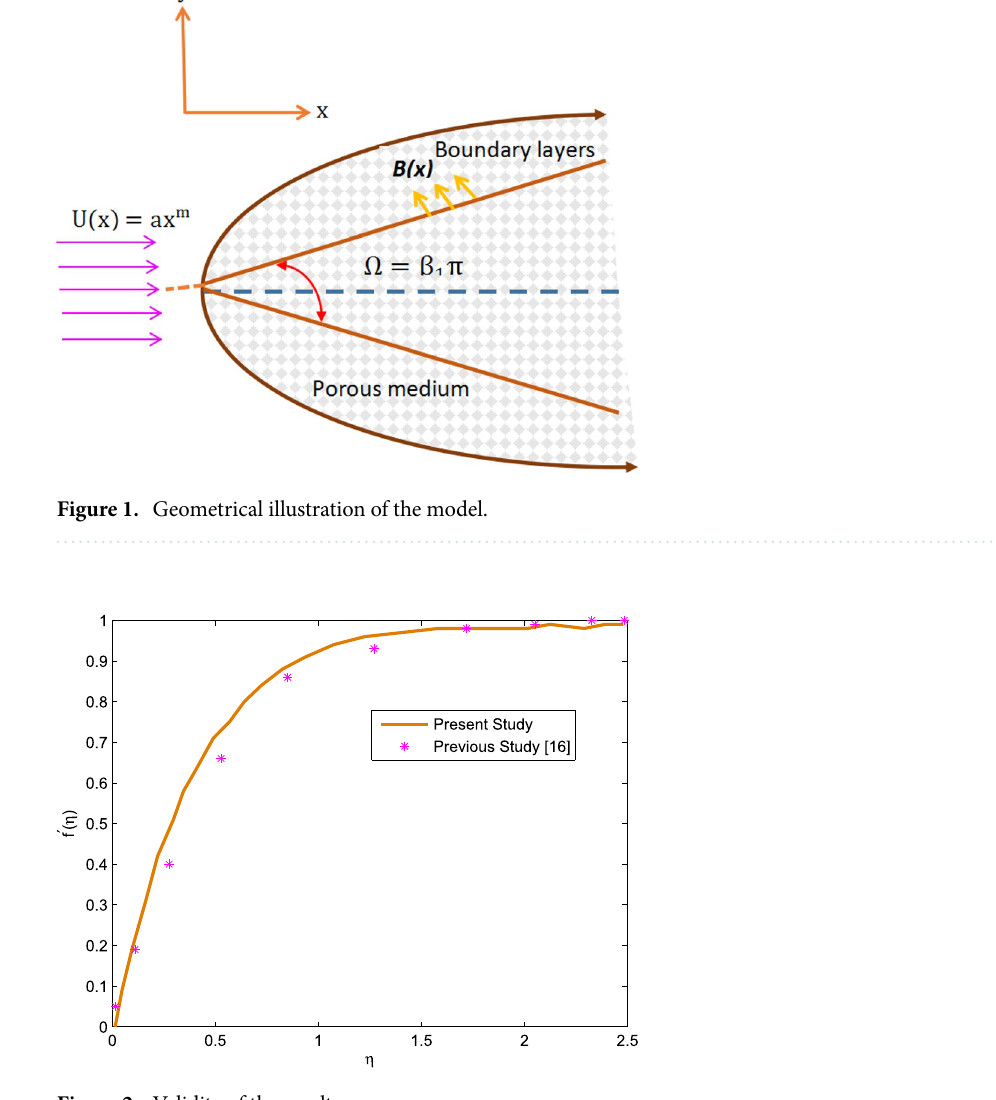
Figure 2. Validity of the results.